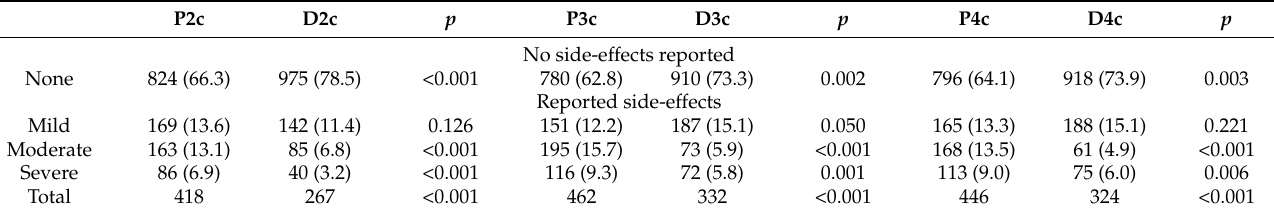
Table 3. Representation of answers to questions by intensity of side